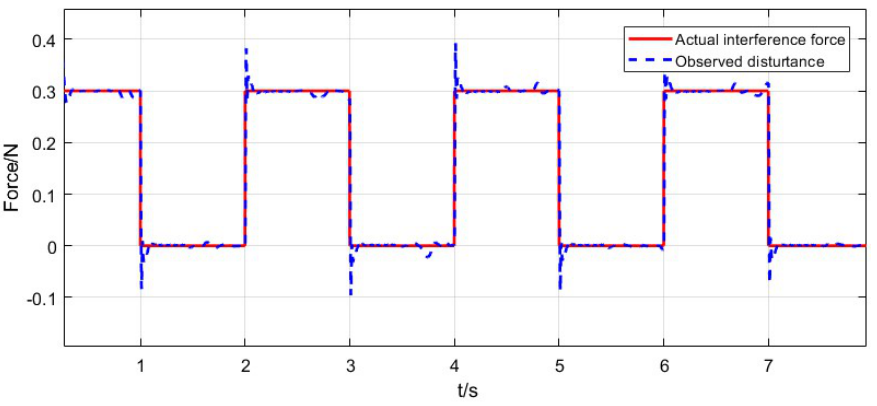
Figure 5. Observation effect diagram of